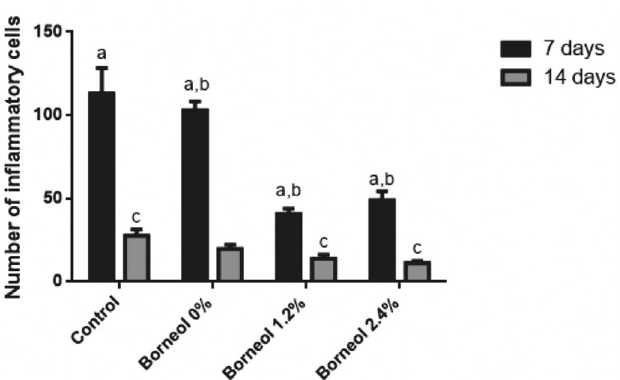
FIGURE 8 - Percentage collagen according to group. a p<0.05: Control vs. Borneol 1.2% and Borneol 2.4% (7 days) ; b